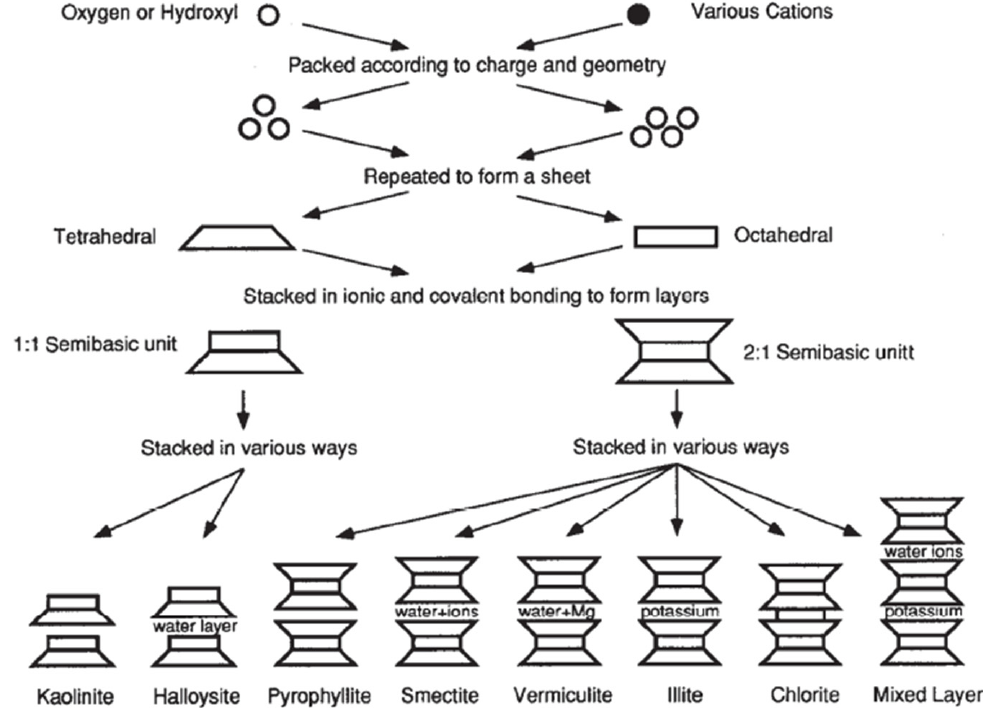
Figure 5. Structural charts of clay minerals. Reprinted with permission from Ref. [4]. Copyright: 2013, Mathieu Antoni. Published by Swiss Federal Institute of Technology Lausanne.